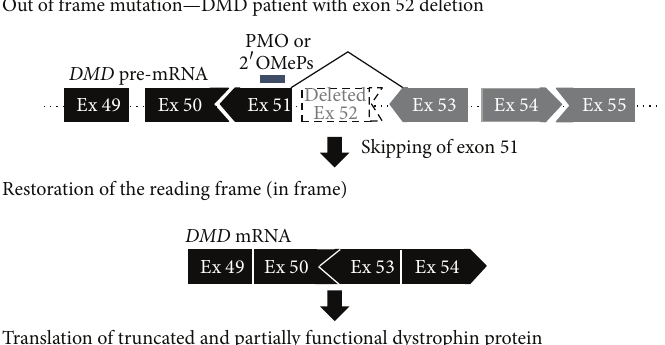
Figure 3: Strategy for exon 51-skipping in Duchenne muscular dystrophy. Exon 51-skipping by appropriate PMO or 2 󸀠 OMePS, indicated by a blue line, can restore the reading frame of dystrophin in a DMD patient, who lacks exon 52 in the mRNA of the DMD gene, leading to out-of-frame products. Dot line and Ex indicate introns and exons,